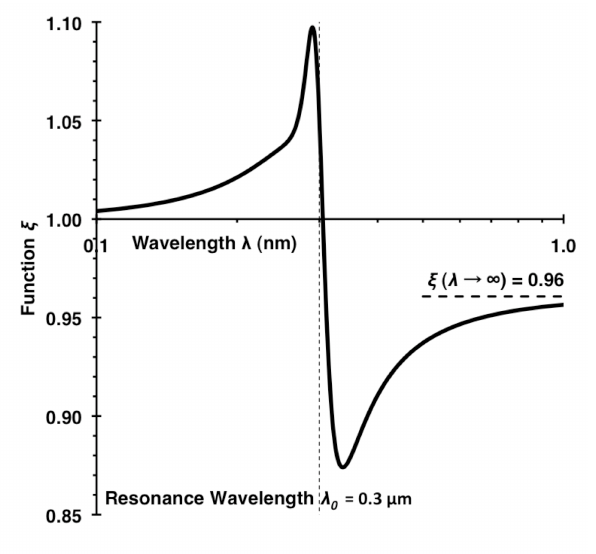
Fig. 6. Function ξ for the complex refractive index m = n + ik speci- fied in Eq. (4) as a function of wavelength λ (logarithmic scale) with the resonance wavelength λ 0 = 0 . 3µm shown as a vertical dashed line and the long wavelength limit of ξ as a horizontal dashed line. Note that ξ depends only weakly on the wavelength resulting in ab- sorption cross-sections for small spherical particles that have wave- length dependence very similar to that of the bulk absorption coef- ficient.